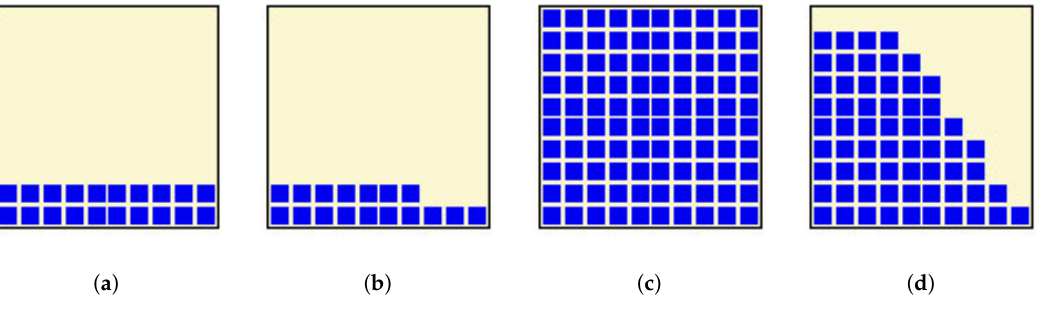
Figure 7. Representations of the expected LEDs viewed from the different locations as simulated: ( a ) at T1; ( b ) at T2; ( c ) at T3; and ( d ) at T4 as defined in Table